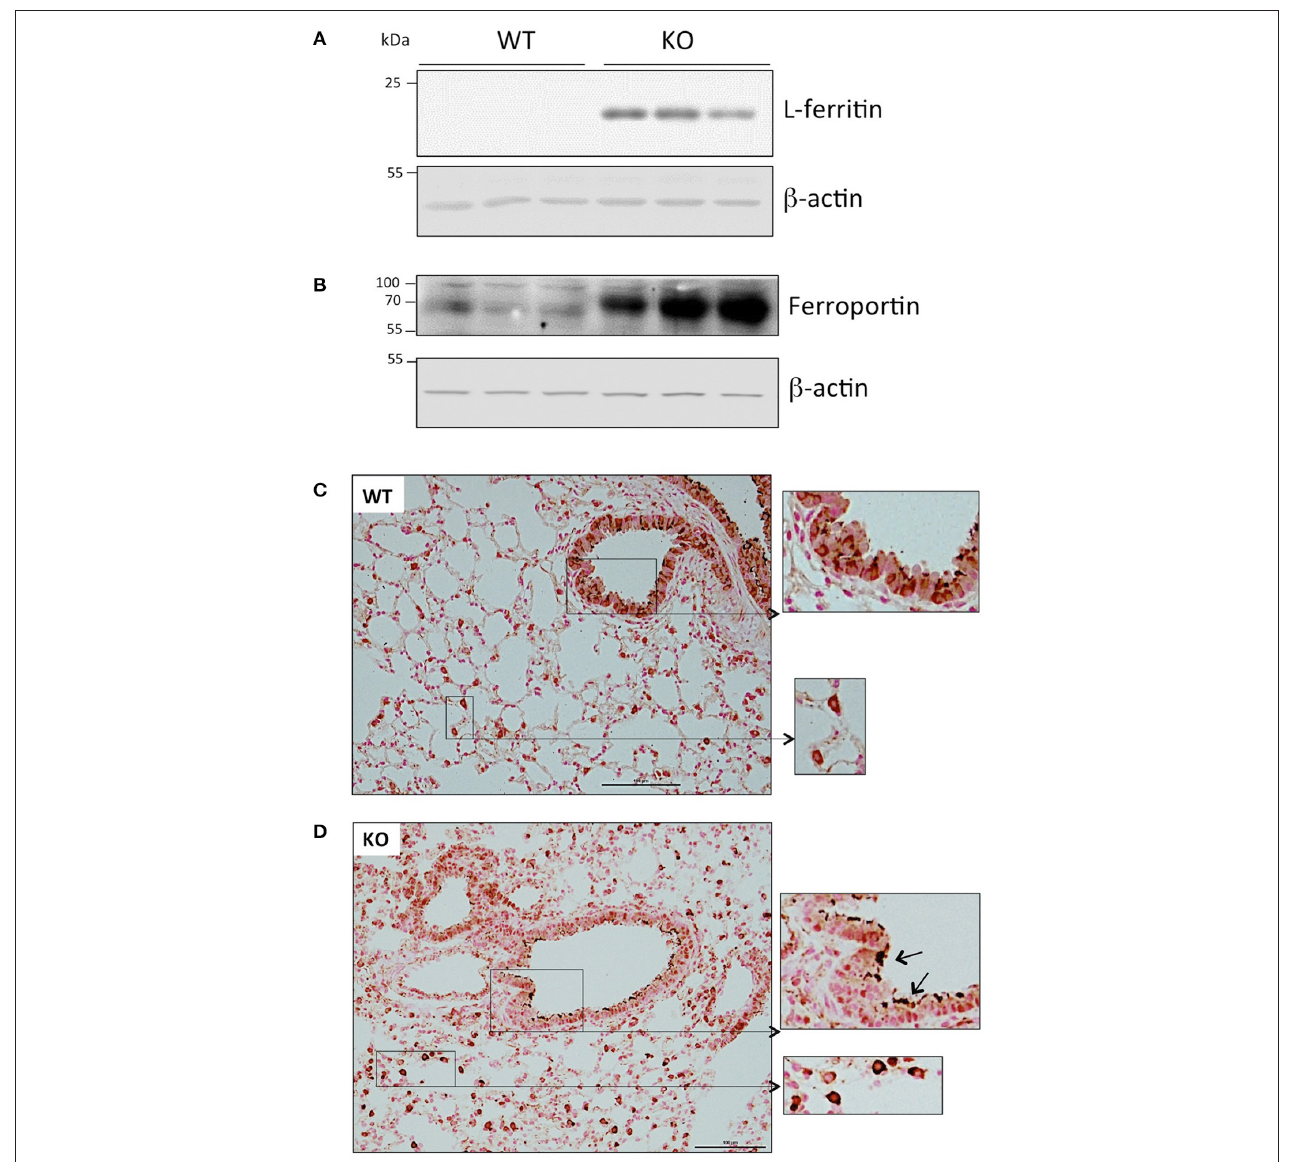
FIGURE 2 | Ferritin and ferroportin expression in the lung of WT and Hepc KO mice: L-ferritin (A) and ferroportin (B) protein levels analyzed by WB using proteins from cytosolic and membrane enriched-fractions, respectively. Ferroportin immunostaining of lung sections from WT (C) and Hepc KO (D) mice. The scale bars indicate 100 µ m and the insets present a two-fold enlargement. Arrows indicate the strong ferroportin staining detected in the apical membrane of the Hepc KO